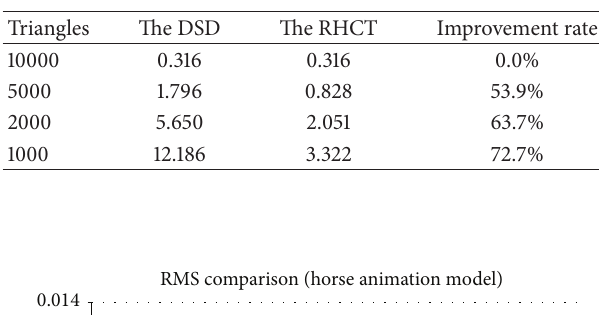
Table 1: RMS error comparison for simplifying horse animation model (unit: 10 − 3 ).